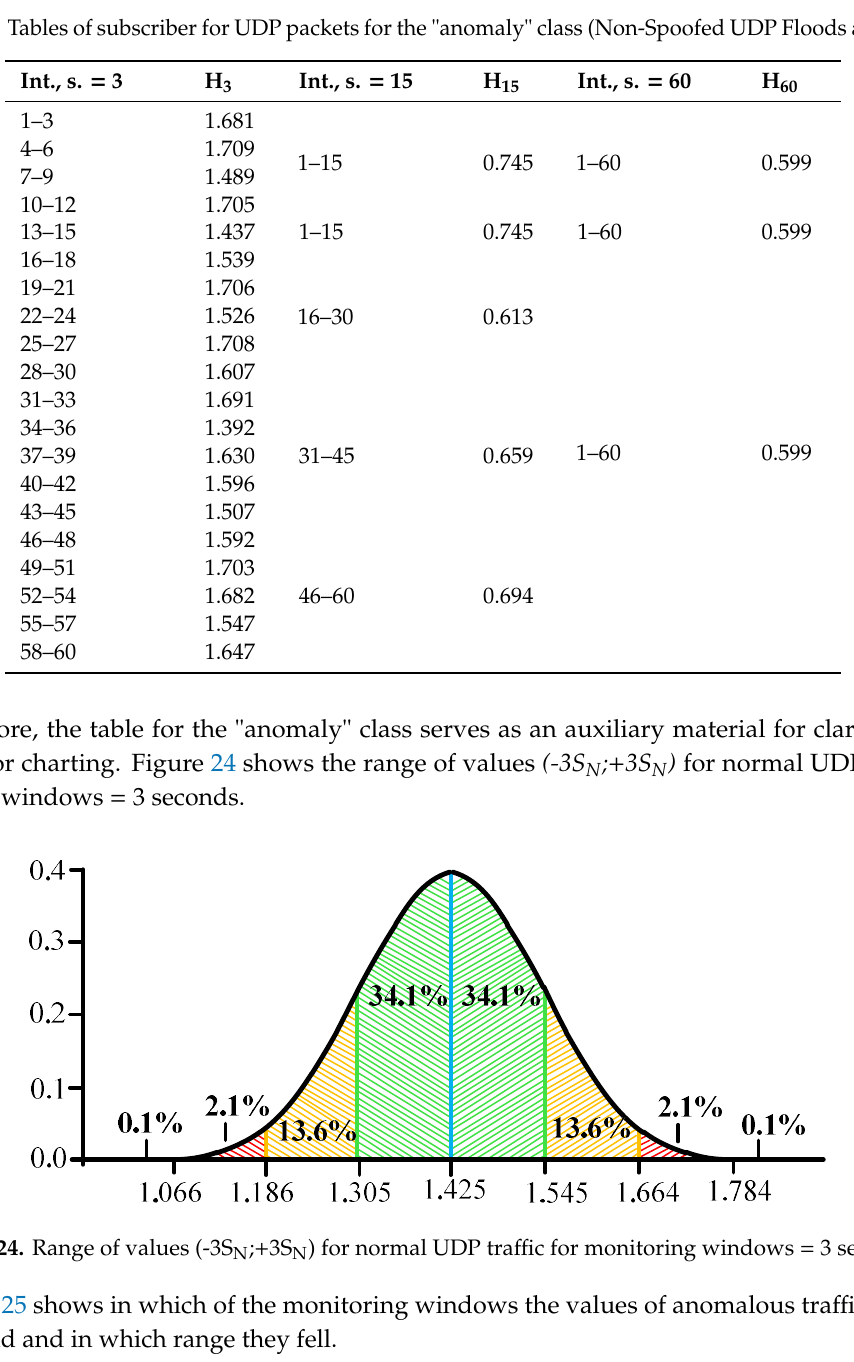
Table 4. Tables of subscriber for UDP packets for the "anomaly" class (Non-Spoofed UDP Floods attack).